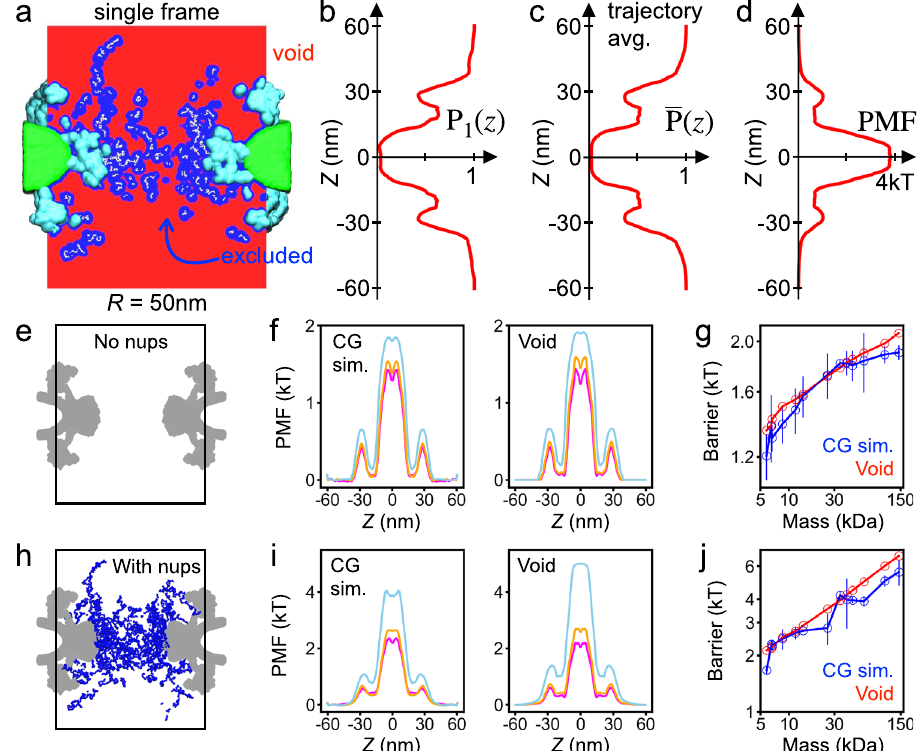
Fig. 4 | Void model of the translocation barrier. a Void analysis map of an instantaneous NPC con fi guration computed using a spherical probe of 22.4 Å radius.Thevolumeavailabletoaccommodatetheprobe(void)isshowninred,the volumeexcludedinblue,FG-nupsinwhite,thescaffoldincyanandthelipidbilayer in green. The image shows a 2D section of a 3D map. b The fraction of the NPC volume thatcanaccommodate the probe without clashes as a function of the pore axiscoordinate. Thefraction wascomputedby splitting the voidanalysis mapinto cylindricalsegmentsof50nmradiusand0.6nmheight,co-axialwiththepore.The data shown were computed for the instantaneous NPC con fi guration displayed in panel a . c Trajectory-averaged probability of accommodating the probe as a function of the pore axis coordinate, P ð z Þ , computed by averaging instantaneous